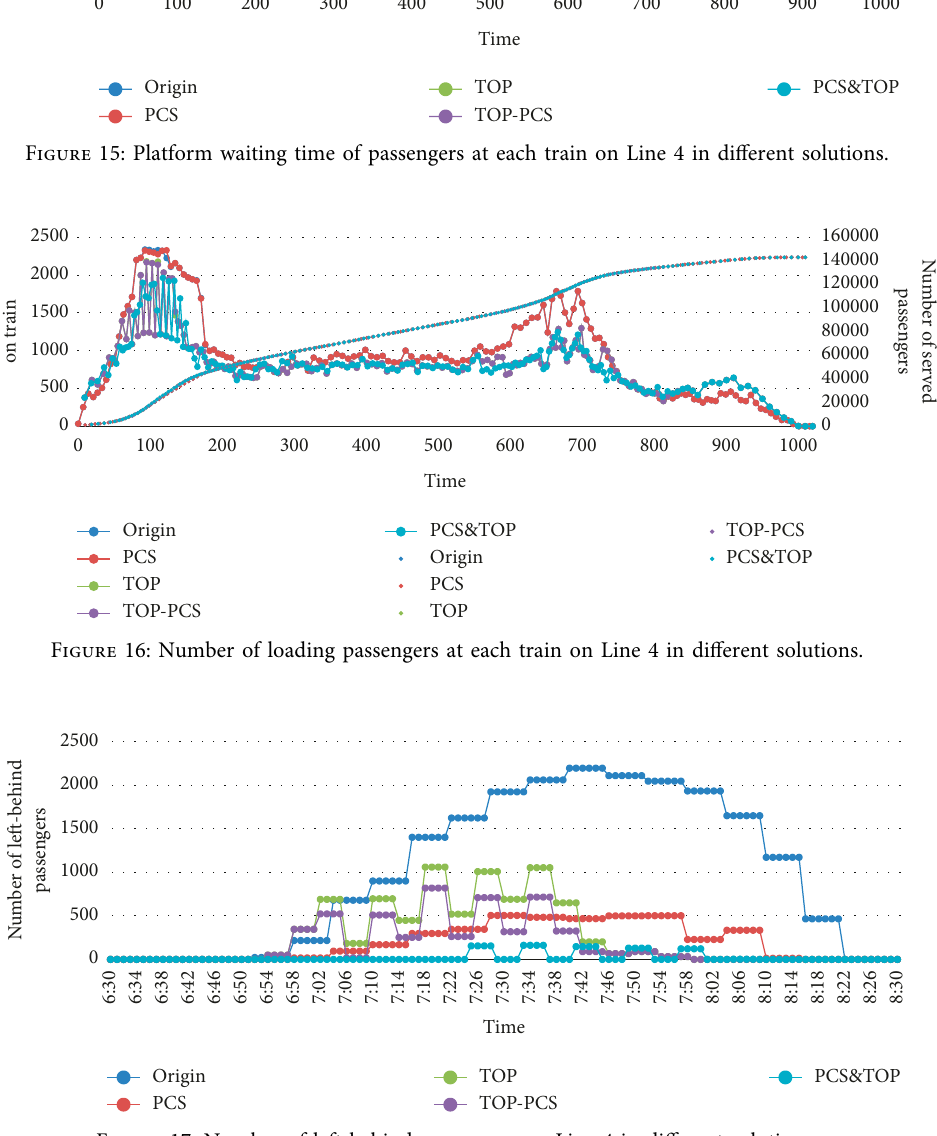
Figure 17: Number of left-behind passengers on Line 4 in different solutions.